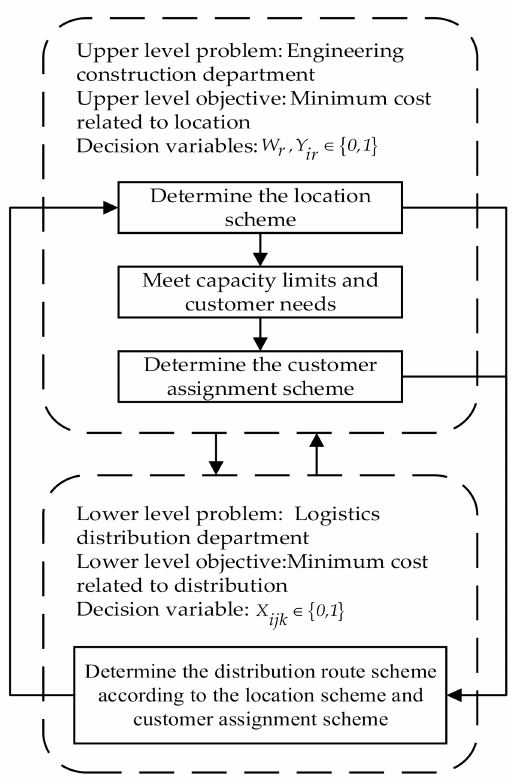
Figure 2. Model solution